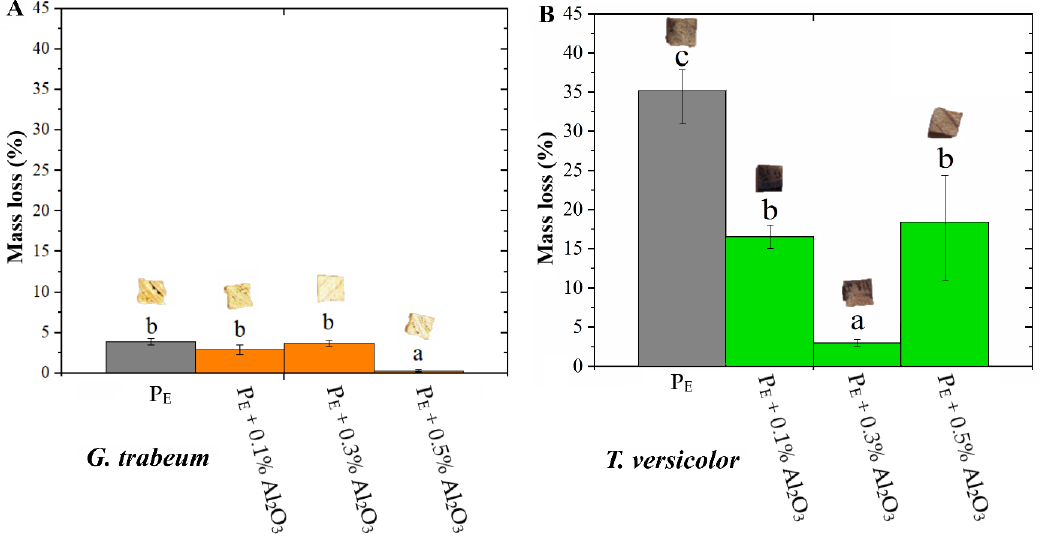
Figure 1. Mass losses of the treated and untreated P. elliottii (P E ) woods exposed to the G. trabeum ( A ) and T. versicolor ( B ) fungi, where different letters above the bars indicate statistically different means.